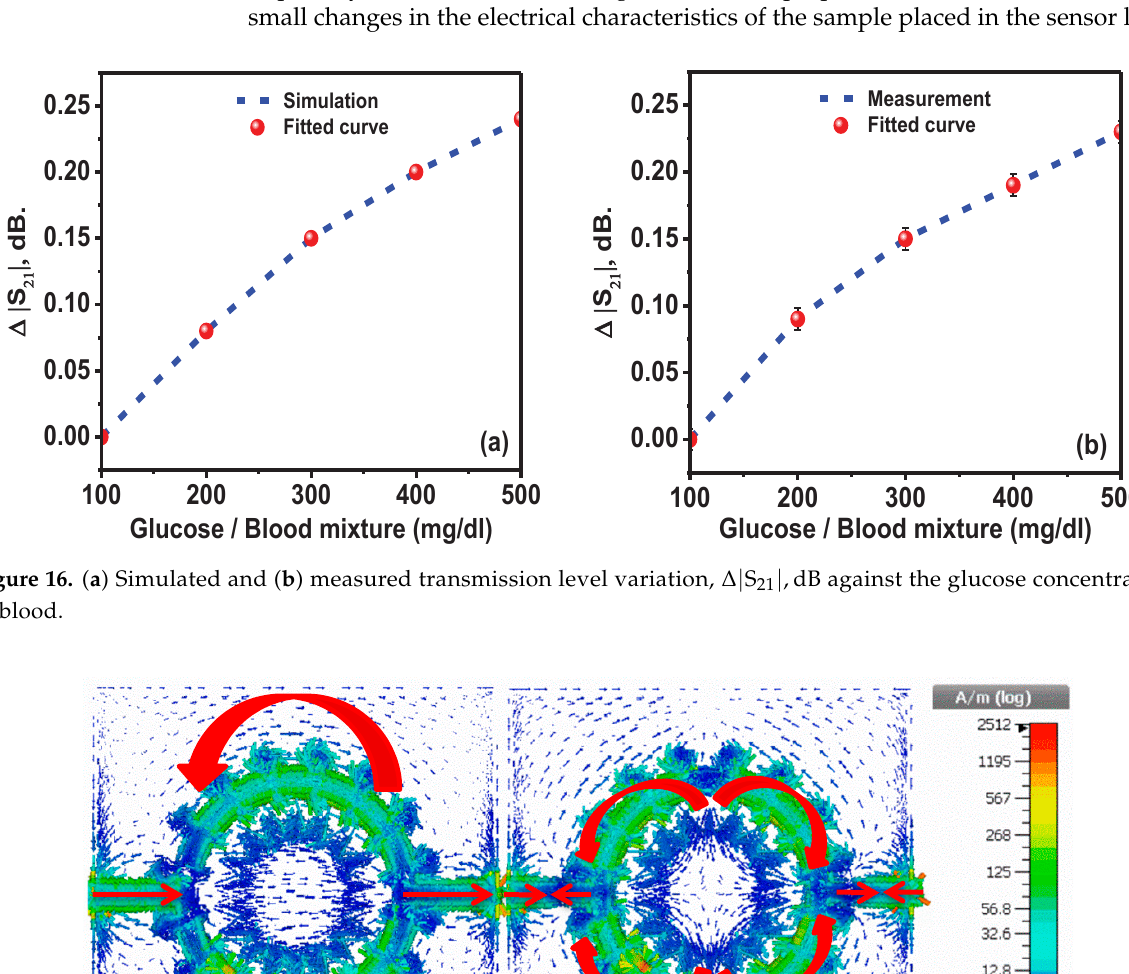
Figure 16. ( a ) Simulated and ( b ) measured transmission level variation, ∆|S (cid:2870)(cid:2869) |,dB against the glucose concentration in blood.